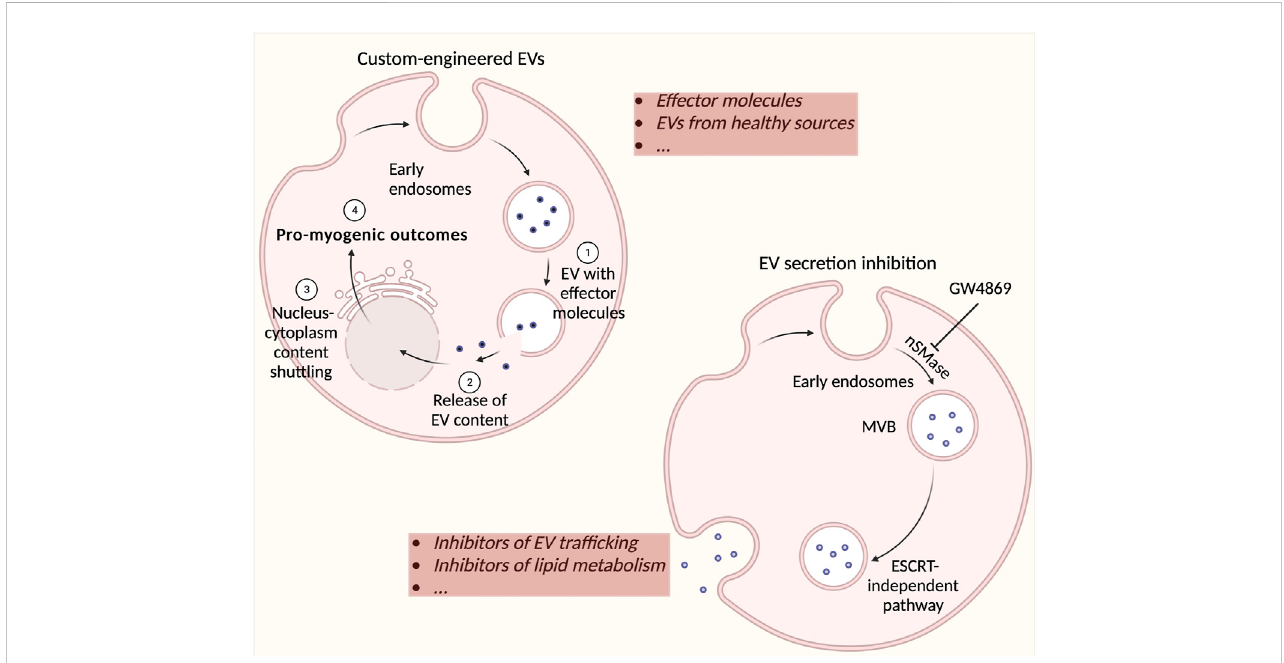
FIGURE 3 Possible strategies for using extracellular vesicles (EVs) as therapeutic agents. Custom cargos may be implemented in speci fi c EVs (such as derived from healthy muscle) and potentially used as a Duchenne muscular dystrophy (DMD) therapeutic. Effector molecules may include nucleic acids, lipids, proteins, adeno-associated viruses (for gene therapy), and propeptides with limited ef fi cacy via direct administration. The inhibition of EV formation and secretion is a new strategy for stopping the effect of detrimental EVs in DMD. Most commonly used compounds include inhibitors of EV traf fi cking such as calpeptin, manumycin A, Y27632, and inhibitors of lipid metabolism such as imipramine, pantethine, and GW4869. These inhibitors may either act on the endosomal sorting complexes required for transport machinery (ESCRT)-dependent (e.g. manumycin A) or – independent pathway (e.g. GW4869). There are a multitude ofotherdrugsthathavebeeninvestigatedfortheirabilitytoinhibitEVsecretionsuchasU0126,clopidogrel,indomethacin,andchloramidine.Thesestrategies represent potentially highly ef fi cacious therapeutics for DMD